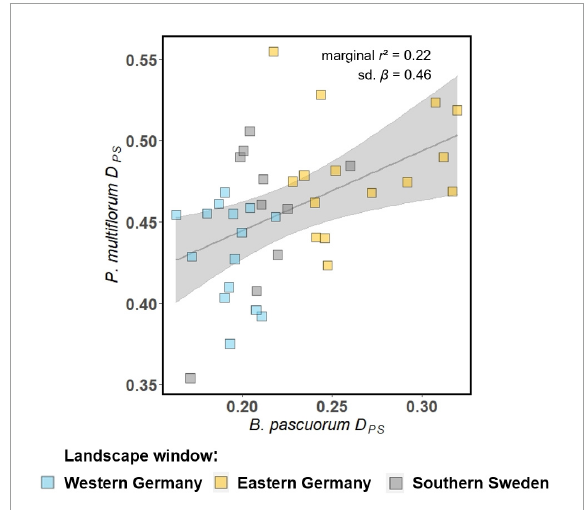
FIGURE5 Effects of genetic indicators of pollinator movement activity of B. pascuorum on pairwise genetic differentiation of the associated forest herb P. multiflorum according to MLPE models. Shown are the global effect of the model (gray line) with p < 0.05 (solid lines), and p < 0.1 (dashed lines), the marginal r 2 and the standardized regression coefficient (sd. β ) (upper-right part of each figure), and the 95% confidence bands are in gray. The filled squares are the partial